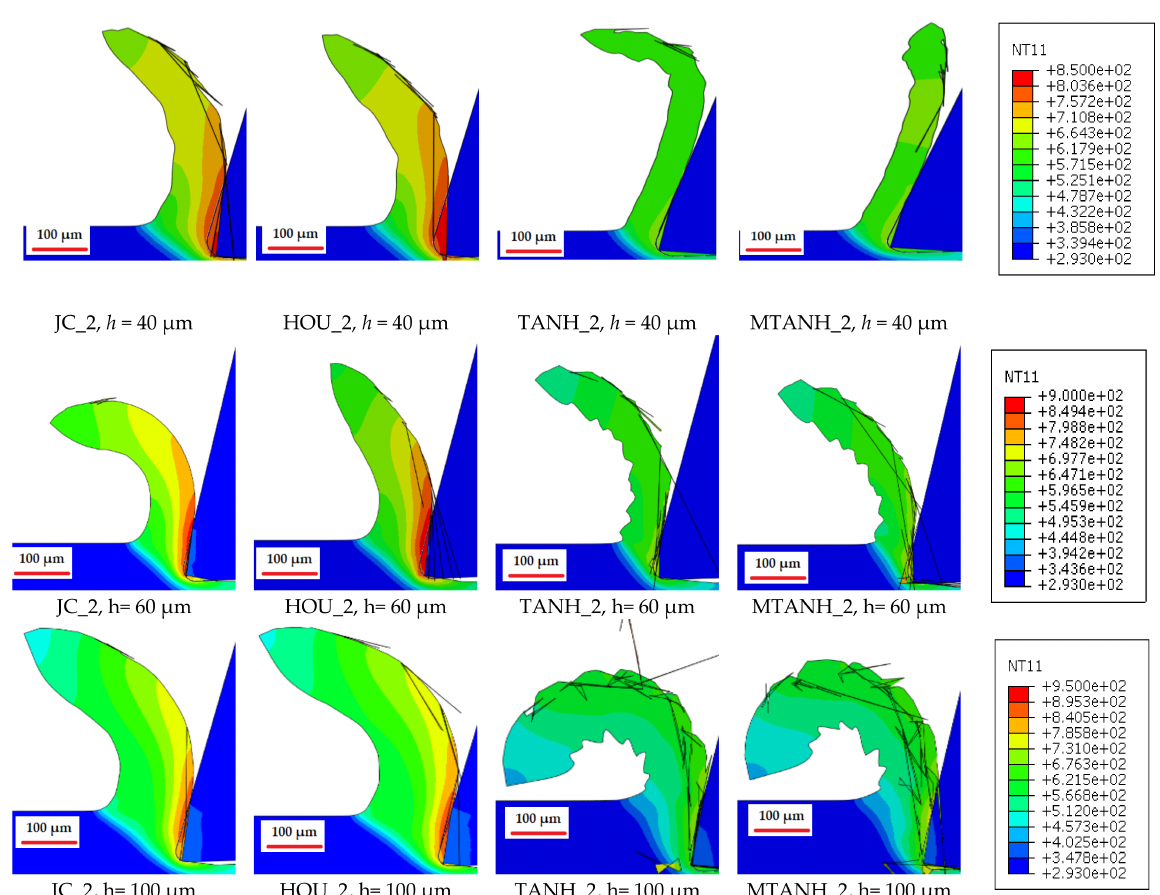
Figure 9. Temperature contour (in K) of four constitutive models with set 2 parameters for uncut chip thickness of 40 µ m, 60 µ m and 100 µ